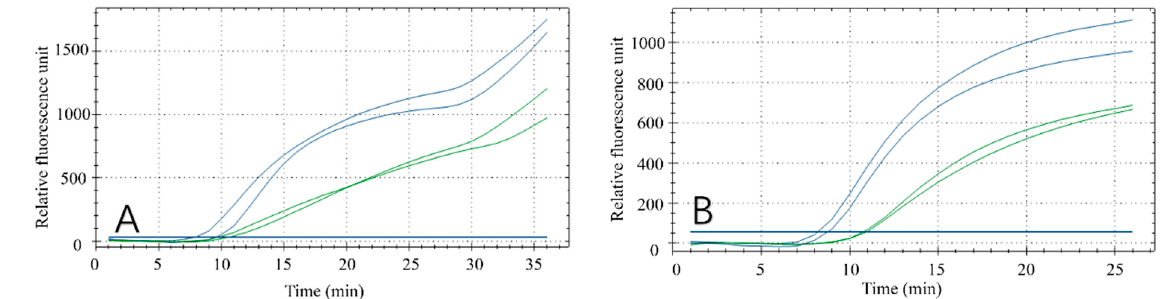
Figure 5. Optimization of reaction time. The green curve was performed with low concentrations of duck meat and the blue curve was performed with high concentrations of duck meat at 30 mins ( A ) and 35 mins ( B ).